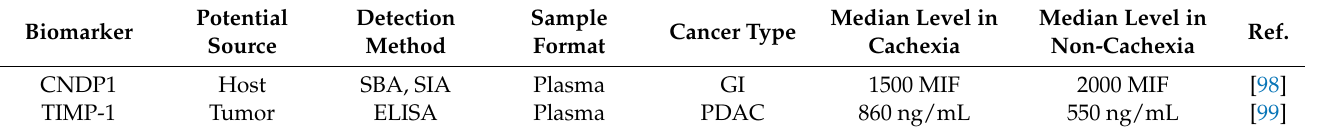
Table 5. Summary of other factors as potential biomarkers of cancer